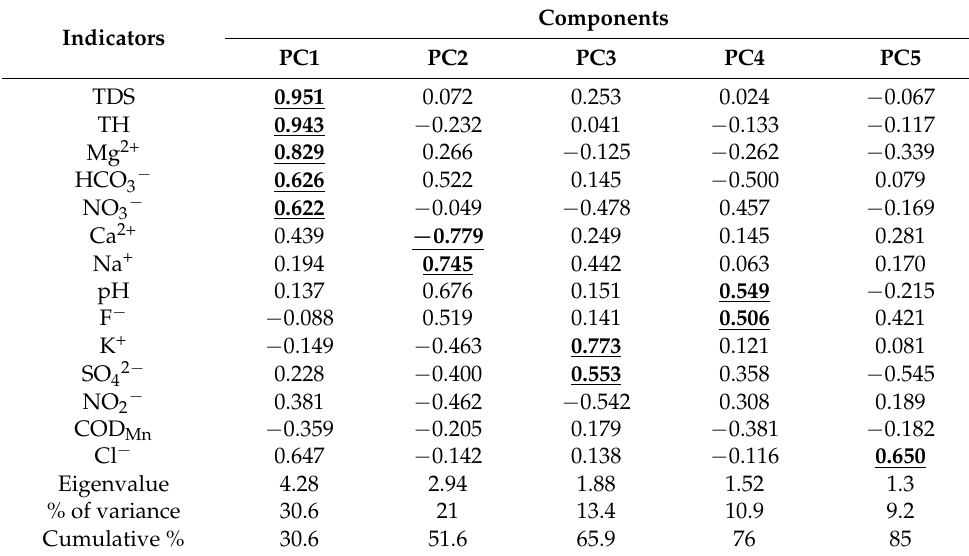
Table 6. Total variance explained of each PC and loadings of